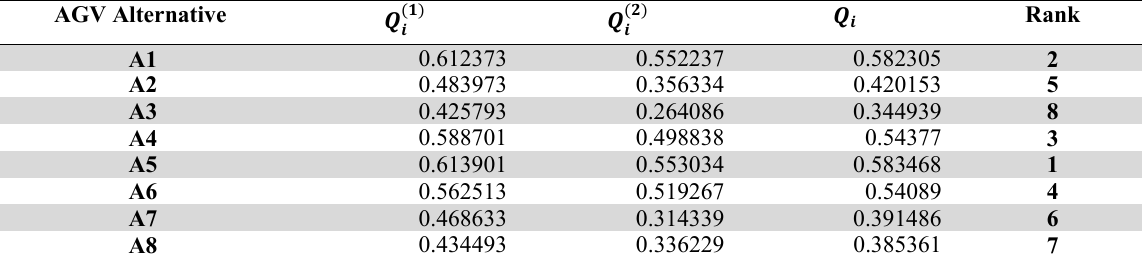
Rank of conveyors using WASPAS AGV